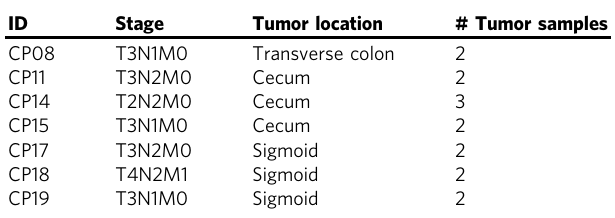
Table 1 Summary of tumor